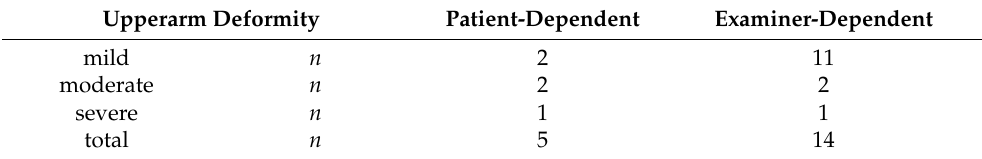
Table 3. Upperarm deformity in study patients ( n = 37) 6 months postoperative.